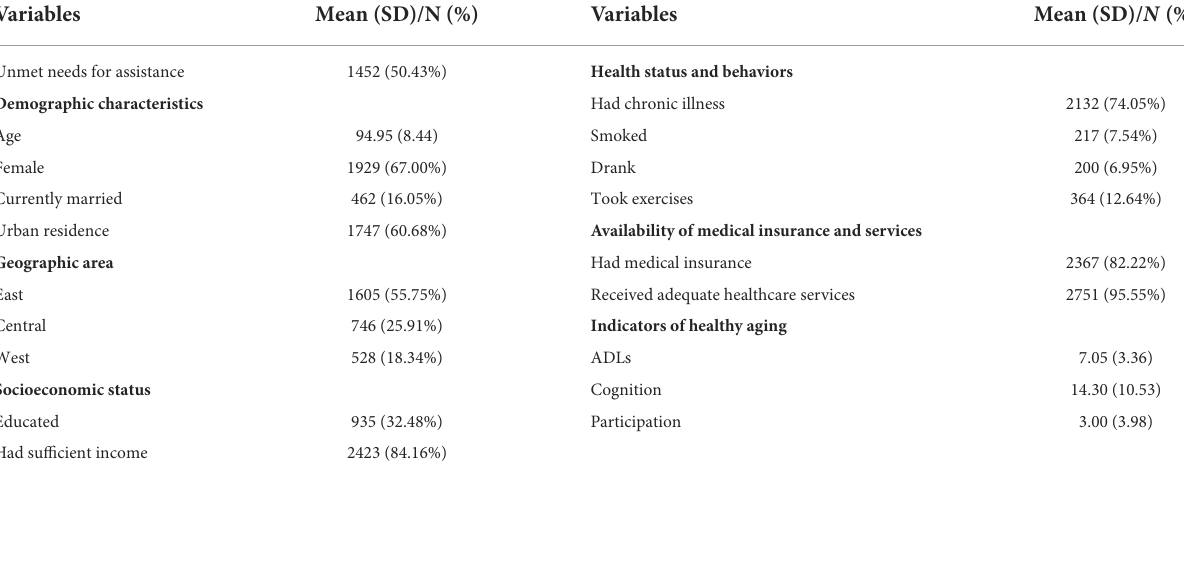
TABLE 1 Sample characteristics (Means/Proportions) ( N =